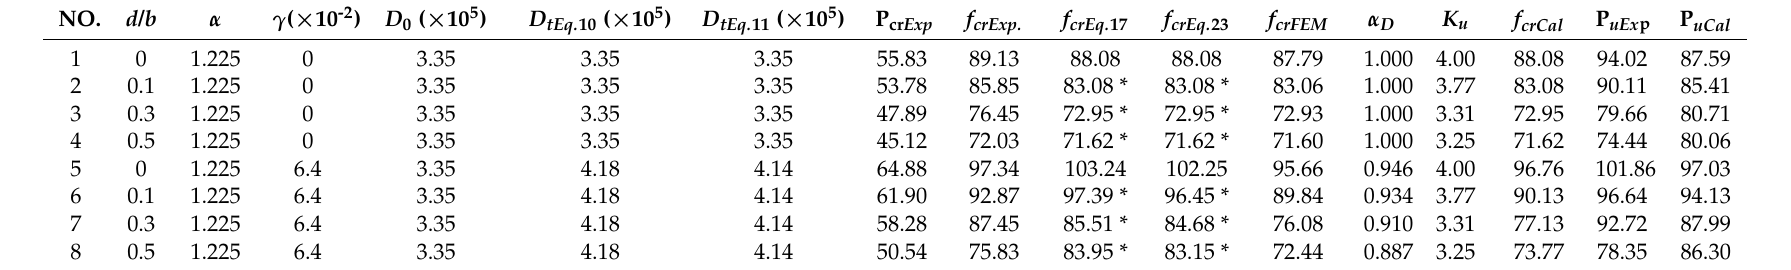
Table 2. The comparison of experimental, theoretical, finite element (FE) models and Calculation method in this